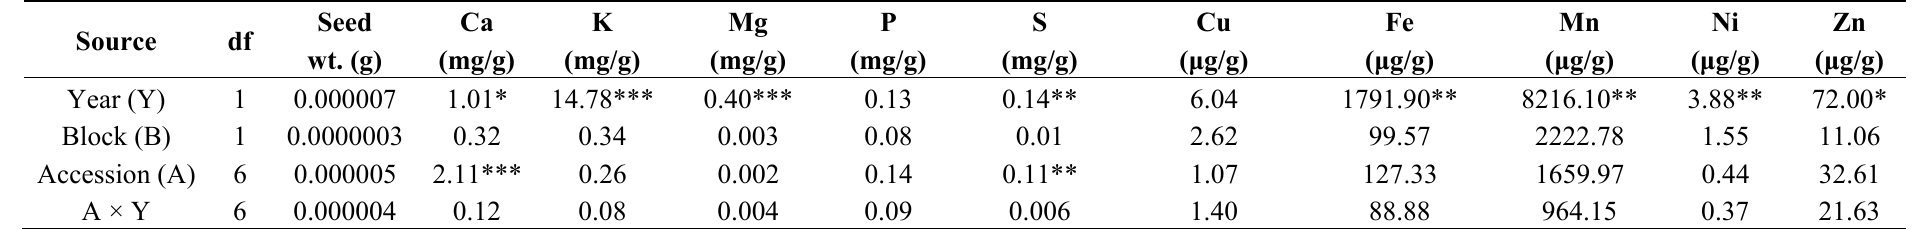
Table 5. Mean squares from analysis of variance of seed wt. (g) and mineral composition (macro-minerals are expressed as mg/g; micro-minerals are expressed as μ g/g dry weight DW) of horse gram seeds harvested from seven accessions (A) and grown in two years (Y).